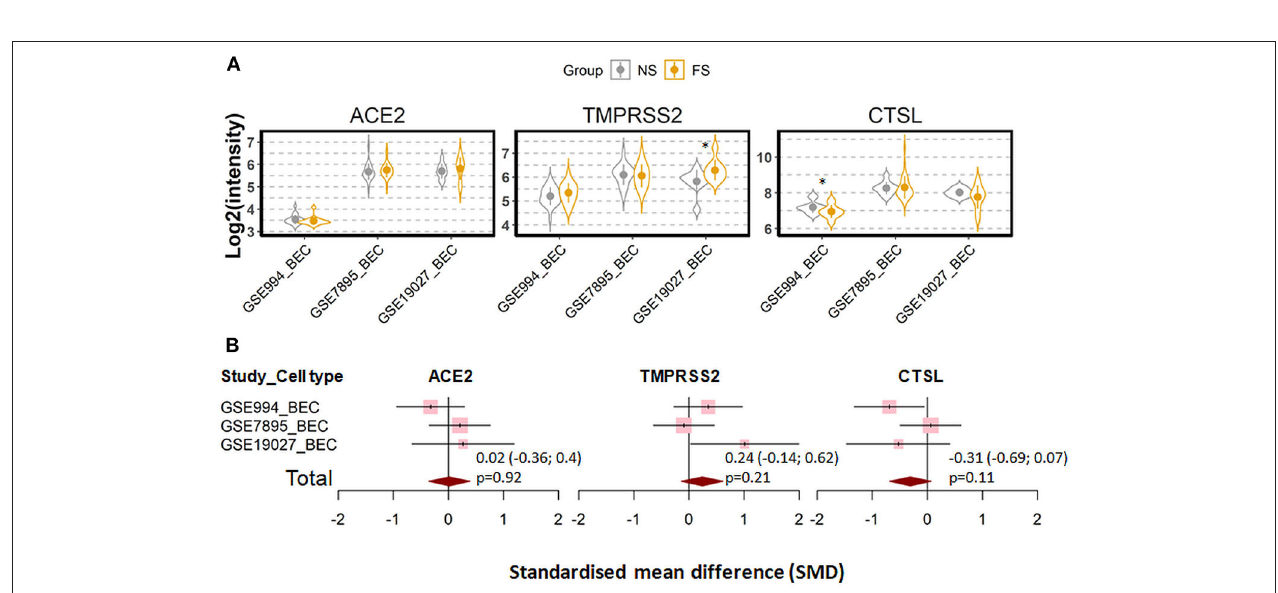
FIGURE 4 | Expression of ACE2, TMRPSS2 and cathepsin L (CTSL) in the airway epithelial cells of healthy never smokers (NS) and former smokers (FS). (A) Violin plot of expression levels of ACE2, TMPRSS2, and CTSL in three datasets which contain current smokers and former smoker. BEC, bronchial epithelial cells. Statistical difference was calculated by Student’s t -test. * p < 0.05. (B) Forest plot of three datasets examining expression of ACE2, TMPRSS2, and CTSL in never smokers and former smokers. The x-axis indicates the standardized mean difference (SMD), while the y-axis shows GEO datasets and cell types. The SMD, 95% CI and P -values of meta-analysis are